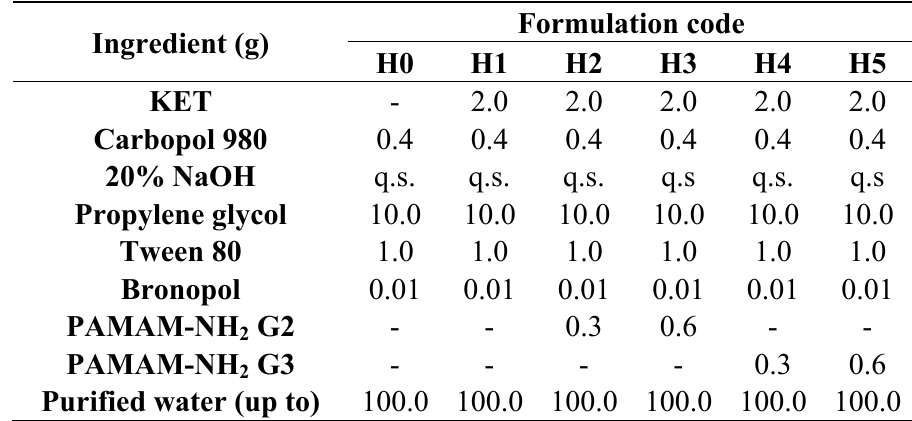
Table 3. Formulation of prepared hydrogels.